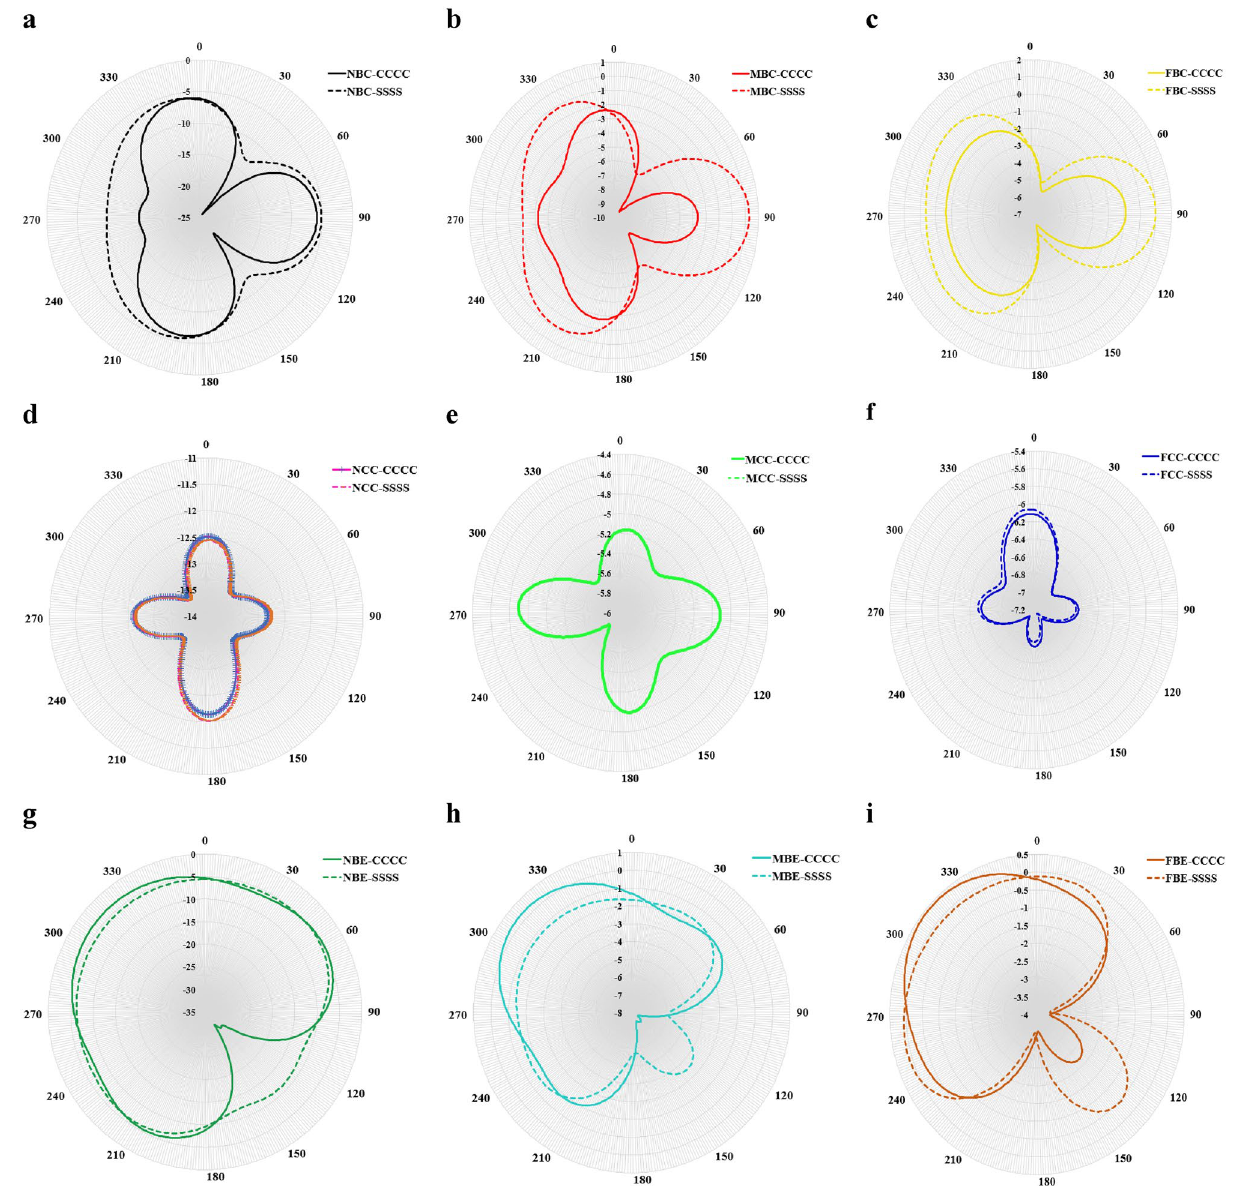
Figure 15. Boundary conditions comparison of the far-field directivity of sound pressure for different location of sound source at f = 1000 Hz ( a ) NBC, ( b ) MBC, ( c ) FBC, ( d ) NCC, ( e ) MCC, ( f ) FCC, ( g ) NBE, ( h ) MBE, ( i )